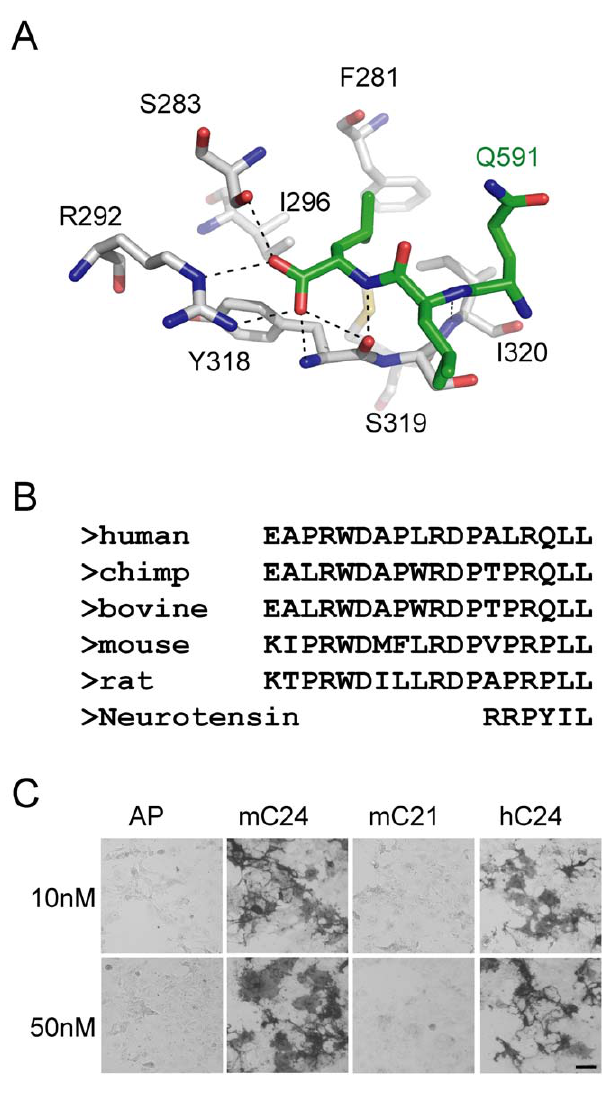
Figure 4. The C-terminal carboxylate of progranulin mediates its binding to sortilin. ( A ) Illustration of binding of progranulin C- terminal tail to sortilin. Drawing was made with Pymol software. Residue backbones of sortilin are labeled in gray and progranulin labeled in green. ( B ) Alignment of the C-terminal residues of progranulin from different species of mammals (from top to bottom: gi|4504151|[Homo sapiens], gi|114666849|[Pan troglodytes], gi|296476263|[Bos taurus], gi|224967126|[Mus musculus], gi|204224|[R- attus norvegicus] ) and neurotensin. ( C ) Mouse progranulin interacts with mouse sortilin through its C-terminal tail. COS-7 cells transfected with mouse sortilin were incubated with 10 or 50 nM of AP tagged C24 and C21 of mouse progranulin (mC24 and mC21) or C24 of human progranulin (hC24). Scale bar=100 m m. doi:10.1371/journal.pone.0021023.g004 3 residues of progranulin (QLL) are required for binding to sortilin, which are similar to the amino acid composition of neurotensin C-terminal residues (YIL).